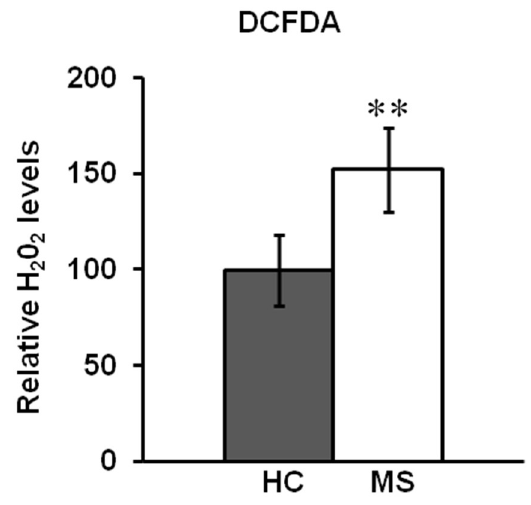
Figure 2. H 2 O 2 production in PBMC of HC and MS patients. H 2 O 2 level was detected spectrofluorimetrically by dichlorodihydrofluorescin (DCFDA) probe. The mean of HC was set to 100% and the mean value of MS expressed as percentage of intensity of fluorescence respect to HC. The histograms represent the means of values ± SEM. (** p < 0.01; Student’s t